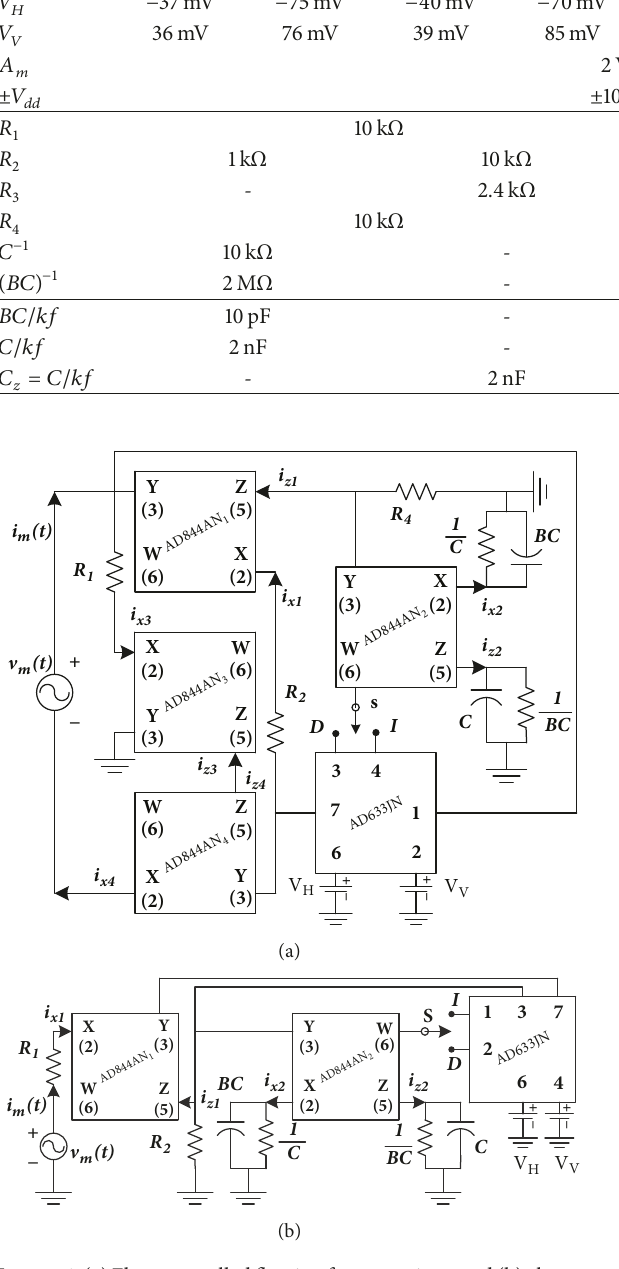
Table 2: Component list of Figure 4(a), Figure 1 in [15], Figure 4(b), and Figure 5 in [18], assuming 𝐶 = 0.1 mF, 𝑘𝑓 = 50 e3, 𝛼 ≈ 1 , and 𝑓 = 20 kHz. Figure 4(a) Figure 1 in [15] Figure 4(b) Figure 5 in [18] Element Inc. Dec. Inc. Inc.